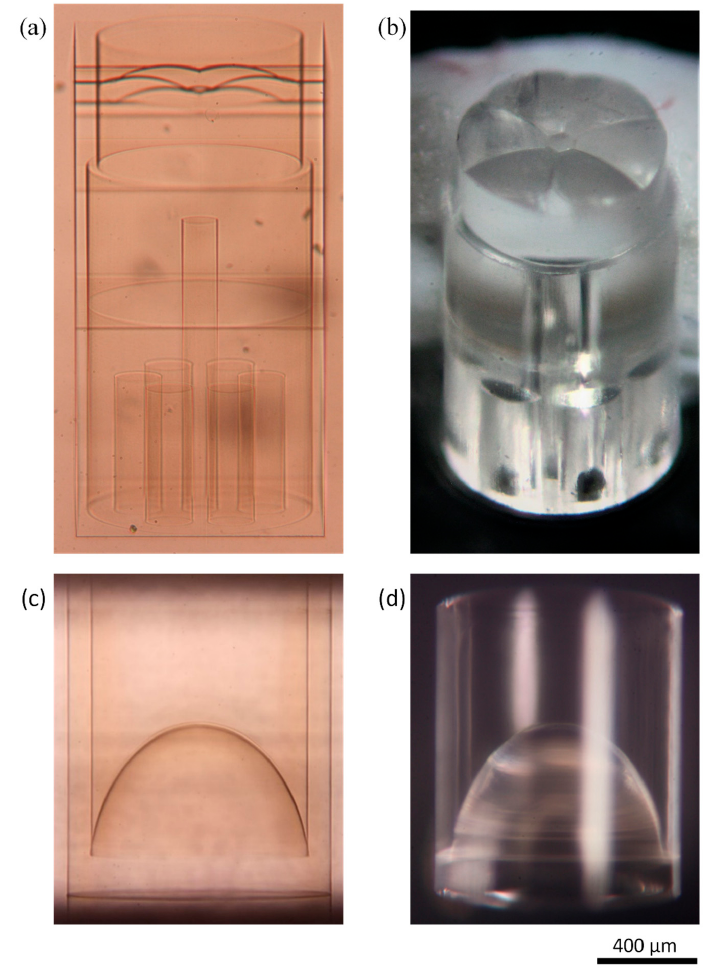
Figure 3. Micrographs of the two distal-end probe components L1 ( a , b ) and L2 ( c , d ) after ultrafast laser inscription ( a , c ) and after etching ( b , d ). The outer diameter of each component was 960 μ m.